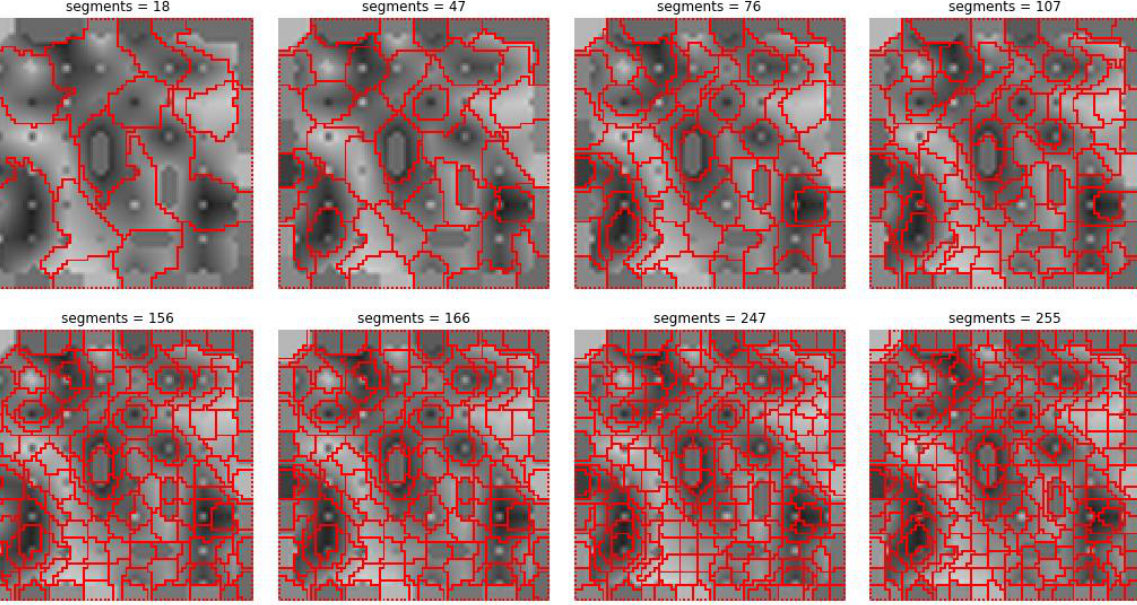
Figure 5. Superpixel segmentation results by SLIC with different input parameter (segments), the titles show the actual number of segments in each figure, the boundaries are represented by red